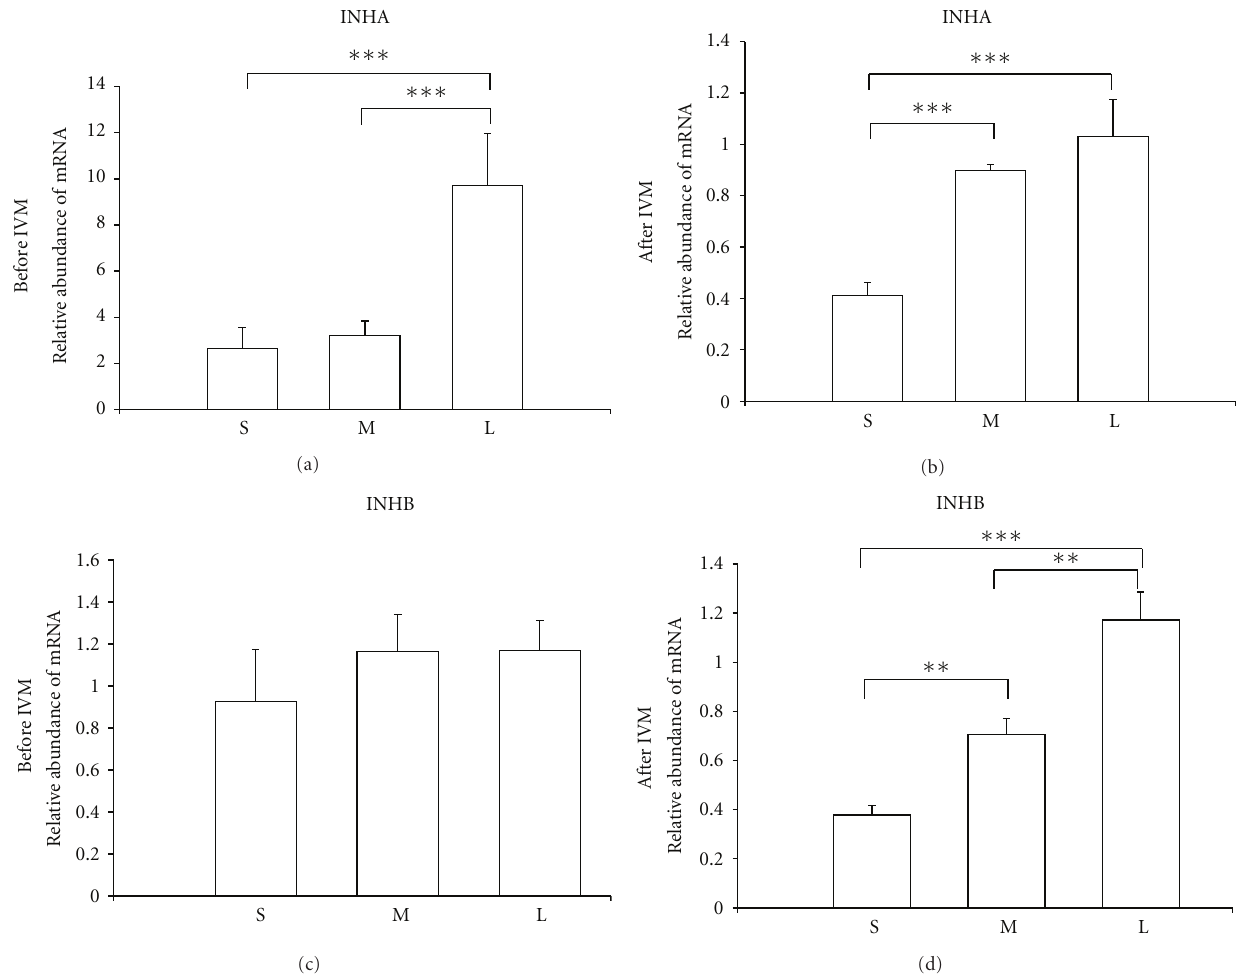
Figure 1: Relative abundance of INHA and INHB transcripts in porcine oocytes isolated from di ff erent size of follicles before and after IVM. The porcine oocytes were isolated from follicles of pubertal gilts and immediately used to isolate RNA, which was reverse-transcribed into cDNA. The relative abundance of INHA (a), (b) and INHB (c), (d) mRNAs was evaluated by RQ-PCR analysis before ((a), INHA, (c), INHB) and after ((b), INHA, (d), INHB) IVM. The oocytes analyzed before or after IVM were isolated from small ( < 3mm), medium (3–5mm) and large ( > 5mm) follicles. Results are presented as mean ± SEM with the level of significance, ∗ P < 0 . 05, ∗∗ P < 0 . 01, ∗∗∗ P < 0 .